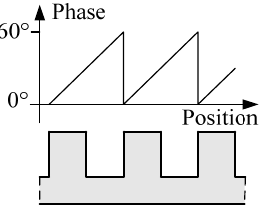
Figure 4. The relationship between the magnetic pole phase and the tooth-slot structure.